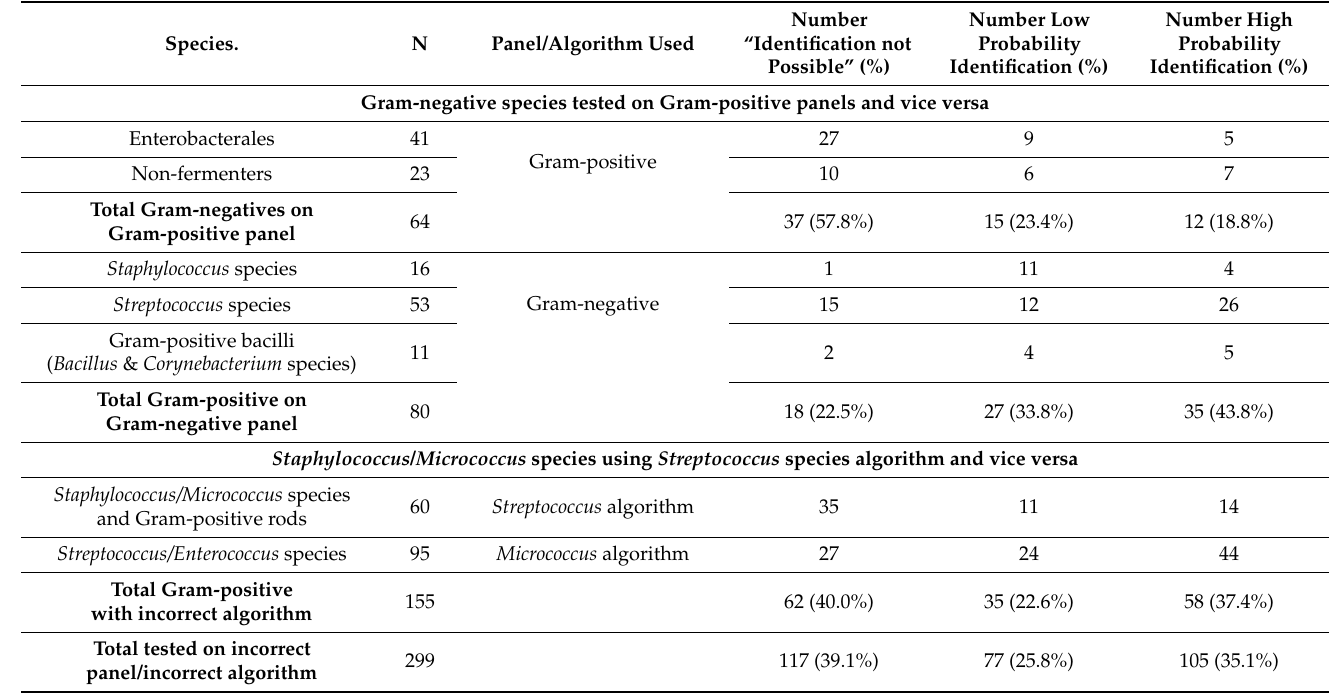
Table 6. Results when isolates were tested on an incorrect panel or using an incorrect algorithm, i.e., inoculation of Gram- negative species on Gram-positive panels or vice versa, or of Gram-positive species incorrectly assigned as “Streptococcus” or “Micrococcus” based on faulty catalase or microscopy results. The expected result for this type of incorrect panel use is “identification not possible”. For Gram-negative species inoculated on Gram-positive panel, we assumed Micrococcus interpretation for the results in this table, as most of them would be catalase positive. Note that all results other than “identification not possible” are wrong; detailed results for each species can be found in Supplementary Table S3. Incorrect identifications with high probability are listed in Table 5. N = total number of isolates